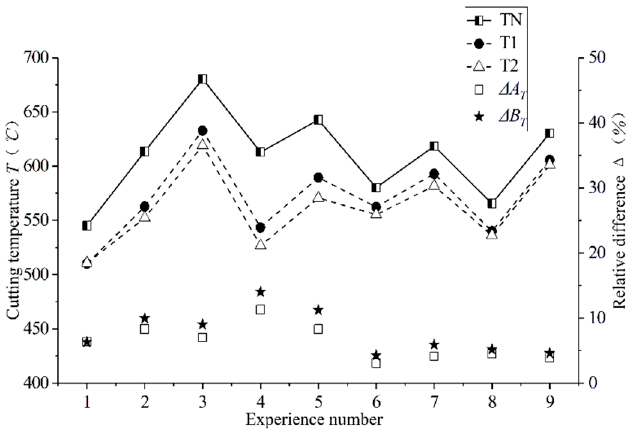
Figure 13. Cutting temperature comparison of different cutting parameters with different cutting tools.